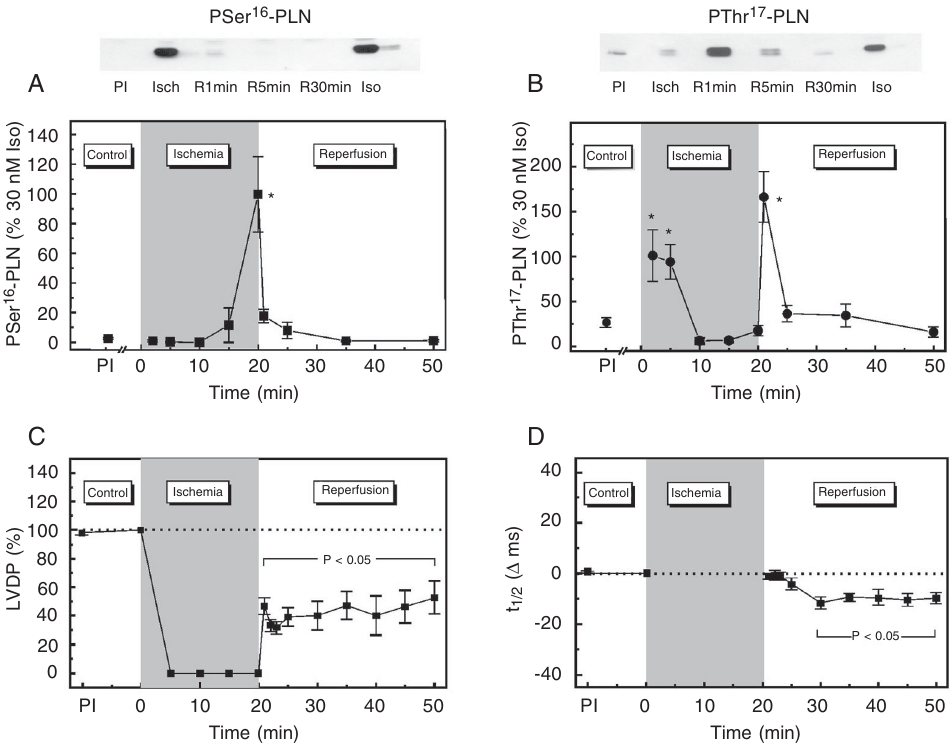
Figure 7. Time course of phospholamban (PLN) Ser 16 and Thr 17 phosphorylation and of left ventricular function during ischemia and reperfusion. Representative immunoblots (A and B, above) and overall results of densitomet- ric analysis of the signals of inmunoblots (A and B, below) of sarcoplasmic reticulum membrane vesicles isolated from hearts freeze-clamped after 20 min of global ischemia (Isch) and at 1, 5, and 30 min during reperfusion (R1- R30 min). The blots were probed with anti PSer 16 -PLN (A) and anti PThr 17 -PLN (B). Phosphorylation of PLN sites induced by 30 nM isoproterenol (Iso) in non-ischemic hearts is shown in the blots for reference. Ser 16 phosphory- lation significantly increased after 20 min of ischemia and Thr 17 phosphorylation transiently increased at 2-5 min of ischemia and at 1 min of reperfusion. Left ventricular developed pressure (LVDP) (C) decreased to virtually non- detectable levels after cessation of flow and reperfusion resulted in a partial recovery of contractility. In spite of the impairment in contractility, t 1/2 (D) recovered immediately after ischemia and then significantly decreased below pre-ischemic values (PI), indicating an acceleration of ventricular relaxation. Points represent the mean ± SEM of data from 51 hearts freeze-clamped at 20 min of ischemia and 1, 2, 3, 5, 15, and 30 min of reperfusion. LVDP is reported as percent PI and t 1/2 as ∆ ms of PI. Site-specific PLN phosphorylation is reported as shown in previous figures. *P < 0.05 compared to PI (Student t -test for paired (mechanical) or unpaired (biochemical) data). Modified from Ref. 35, with